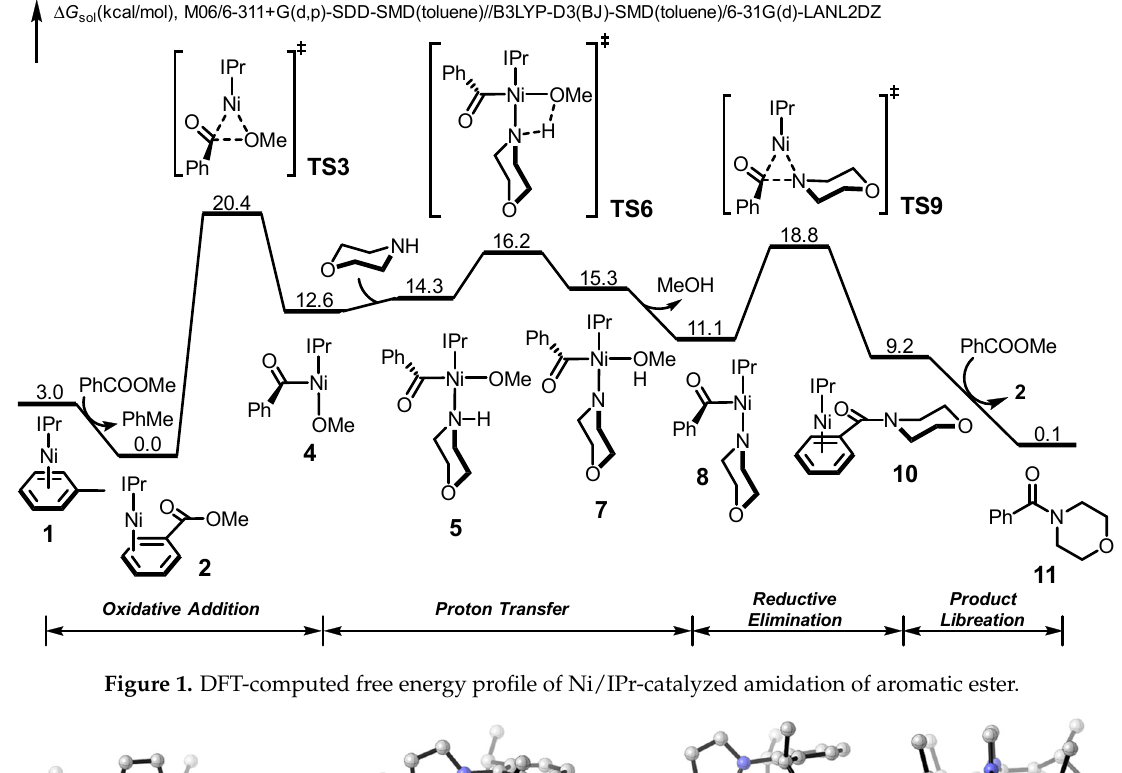
Figure 1. DFT-computed free energy profile of Ni/IPr-catalyzed amidation of aromatic ester.